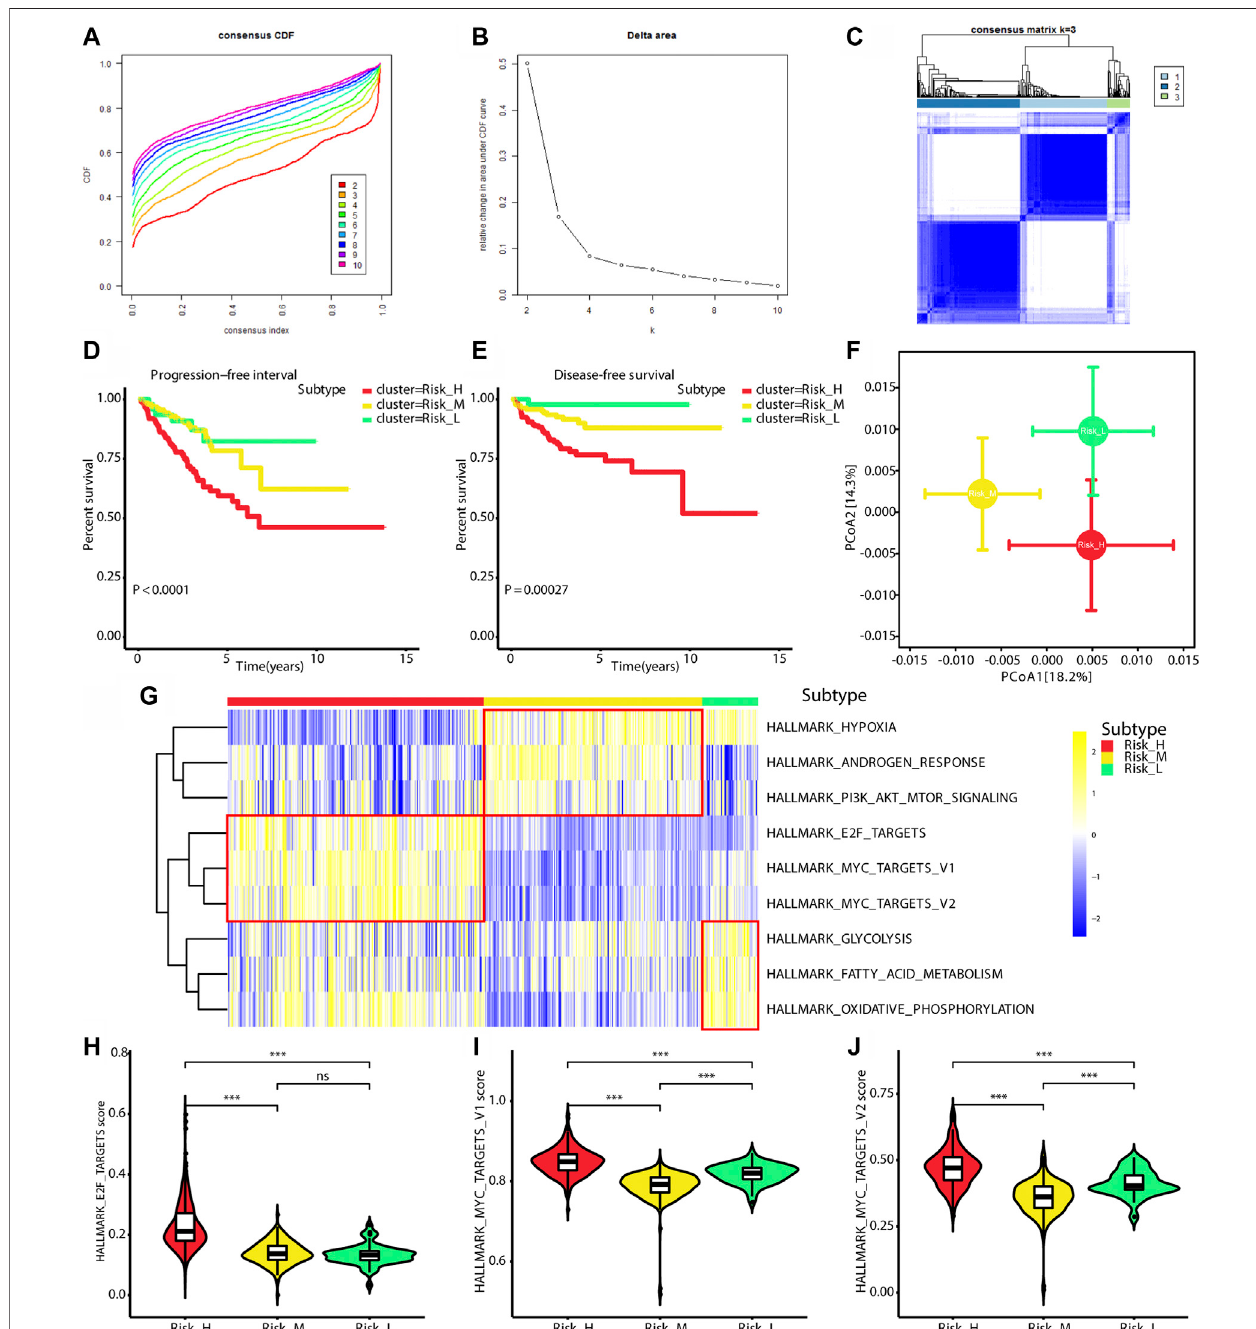
FIGURE1| Identi fi cation ofthreesubtypes withdifferentprognosis. (A) TheCDF curve underdifferentvaluesofk.Thevalueofkrepresentsthenumber ofclusters during the consensus cluster. When the optimal k value is reached, the area under the CDF curve will not signi fi cantly increase with the increase of k value. (B) Relative change in area under CDF curve under different values of k. (C) The consensus matrix obtained when k (cid:2) 3. Consistency values range from 0 to 1, 0 means never clustering together (white), 1 means always clustering together (dark blue). (D) Survival curves for progression-free interval of patients in the different subtypes. (E) Survivalcurves for disease-free survivalofpatients inthe differentsubtypes. (F) PCA ofBray-Curtisdissimilaritiesobtained forthe transcriptional pro fi les. Thecircles and errorbarsindicatethemeanandstandarderrorsofthemean.PERMANOVAtestwith10,000permutationswereperformedtocalculate p value. (G) Theheatmapshows ssGSEA scores levels among three subtypes. (H) The violin plot shows ssGSEA score of HALLMARK_E2F_TARGETS is signi fi cantly highest in Risk_H subtype. (I) The violin plot shows ssGSEA score of HALLMARK_MYC_TARGETS_V1 is signi fi cantly highest in Risk_H subtype. (J) The violin plot shows ssGSEA score of HALLMARK_MYC_TARGETS_V2 is signi fi cantly highest in Risk_H subtype. (PCa, prostate cancer; CDF, cumulative distribution function; PCA, principal coordinate analysis. * means p < 0.05, ** means p < 0.01, *** means p < 0.001, ns means p > 0.05, and p < 0.05 is de fi ned as statistically signi fi cant).